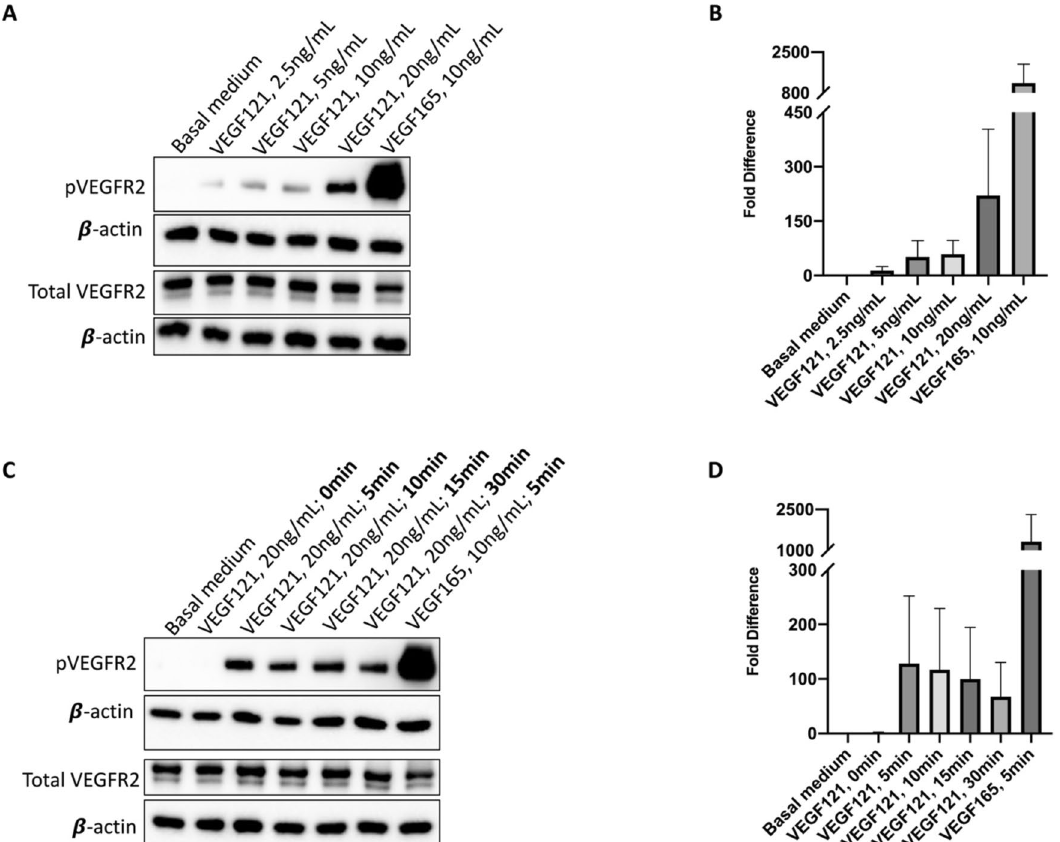
Figure 6. In vitro VEGFR2 activation. In human microvascular lung endothelial cells (HMVEC-L), VEGF121 activated VEGFR2 in a dose dependent manner, although with marked decreased potency compared to VEGF165 in representative immunoblots ( A , B ). On an induction study, increased incubation time did not improve VEGF121 receptor binding ( C , D ). A representative immunoblot from three independent runs for quality control is pictured ( C ). [Full-length uncropped blots are provided in Supplementary Information File 4. Three-minute exposure, as used in this main figure, is displayed in Supplementary Information File 4A (corresponding to A ), 4C (corresponding to C ), while additional 30 s exposures merged with correlating molecular weight markers, are displayed in Supplementary Information File 4B (corresponding to A ), 4D (corresponding to B )]. The β-actin loading control from each membrane is displayed under the image of the primary antibody of